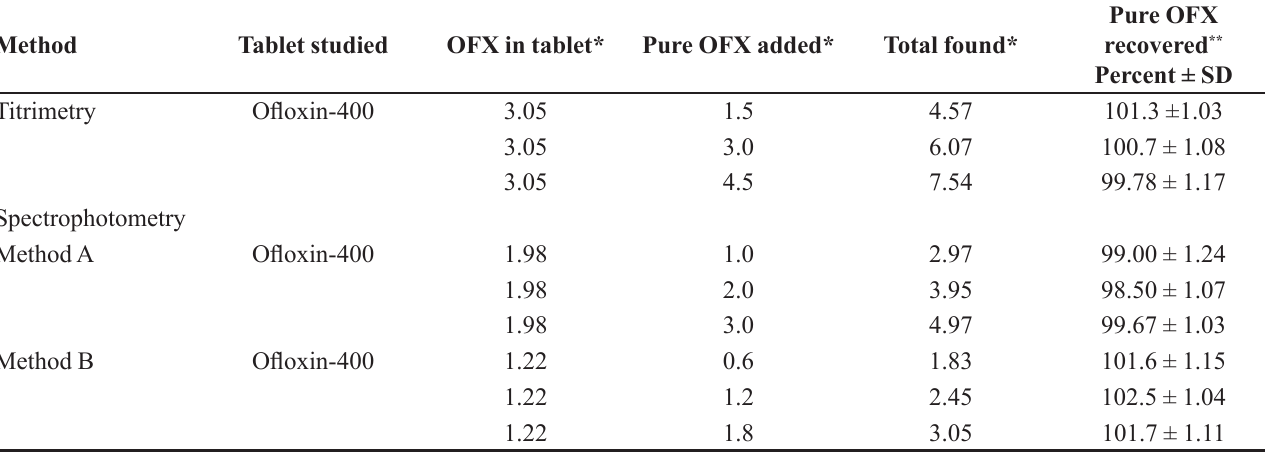
TABLE VI - Accuracy assessment by recovery